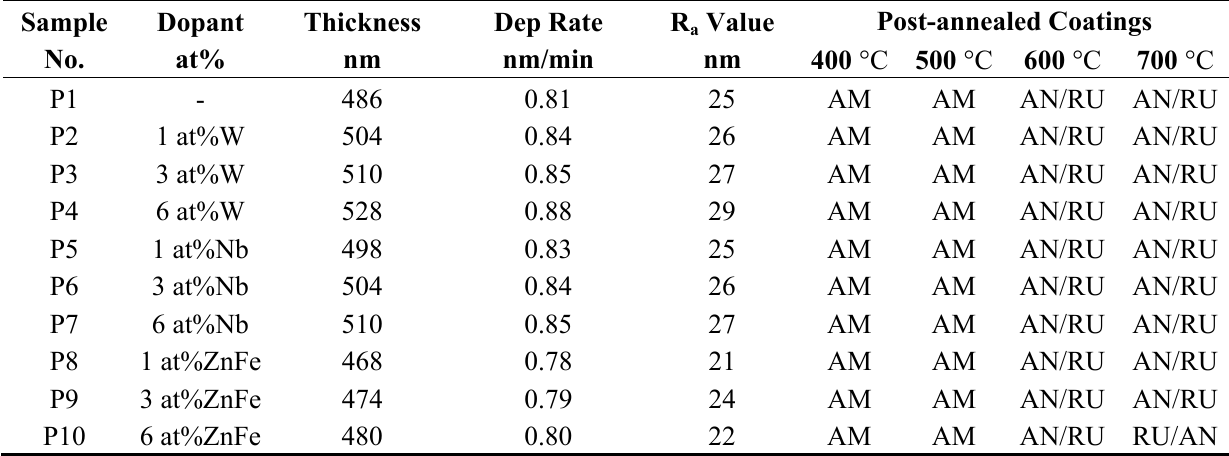
Table 1. Compositional and structural properties of titania and doped titania coatings deposited at 250 kHz-50% duty cycle and at various annealing temperature.